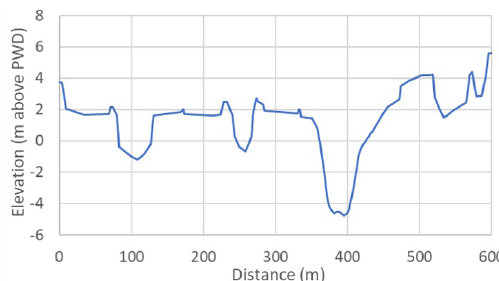
Figure 4. A typical cross section of the Khaprabhanga River.